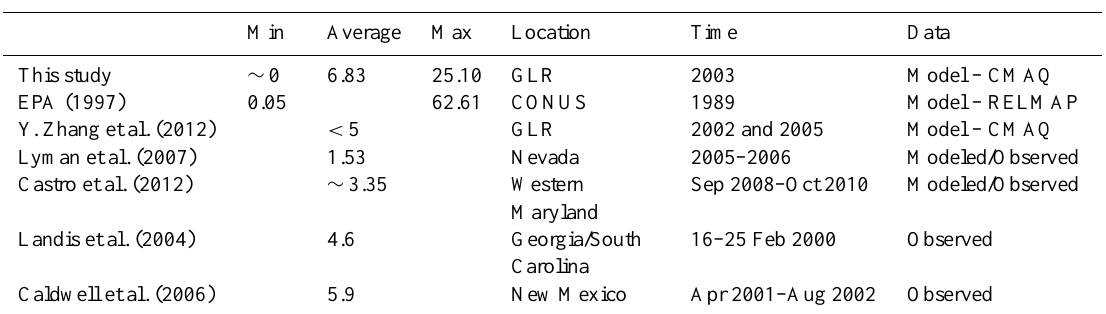
Table A3. Annual total mercury deposition on a per-area basis (µgm − 2 ) . All values are scaled to reflect annual equivalent values. All except Castro et al. (2012) report total deposition of all mercury species; Castro et al. (2012) report only gaseous oxidized mercury, which is expected to be the majority of total mercury deposition. Average, minimum, and maximum annual deposition estimates from CMAQ-Hg are compared with equivalent or scaled values from model and measurement estimates (Caldwell et al., 2006; Castro et al., 2012; EPA, 1997;